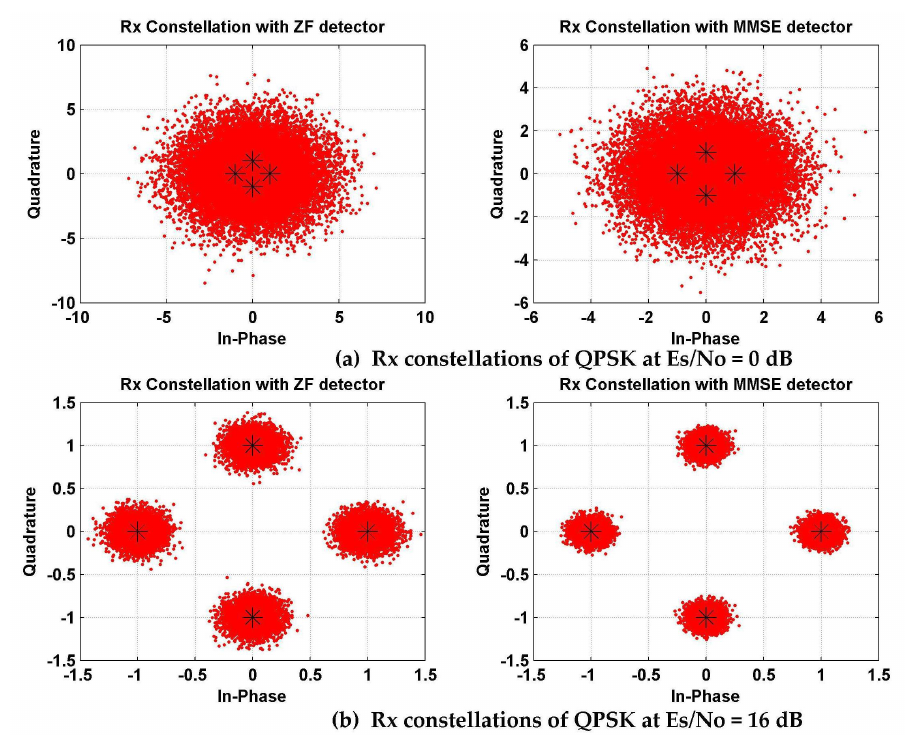
Figure 9. Constellations diagrams for QPSK modem: ( a ) Rx constellations of QPSK at E s / N 0 = 0 dB, ( b ) Rx constellations of QPSK at E s / N 0 = 16